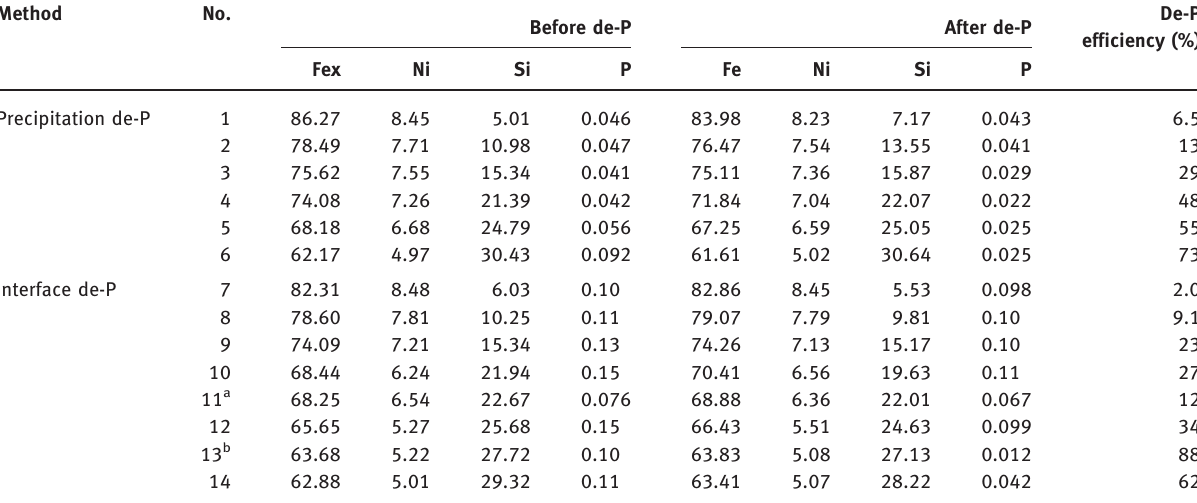
Table 3: The experimental results of two kinds of de-P experiments.